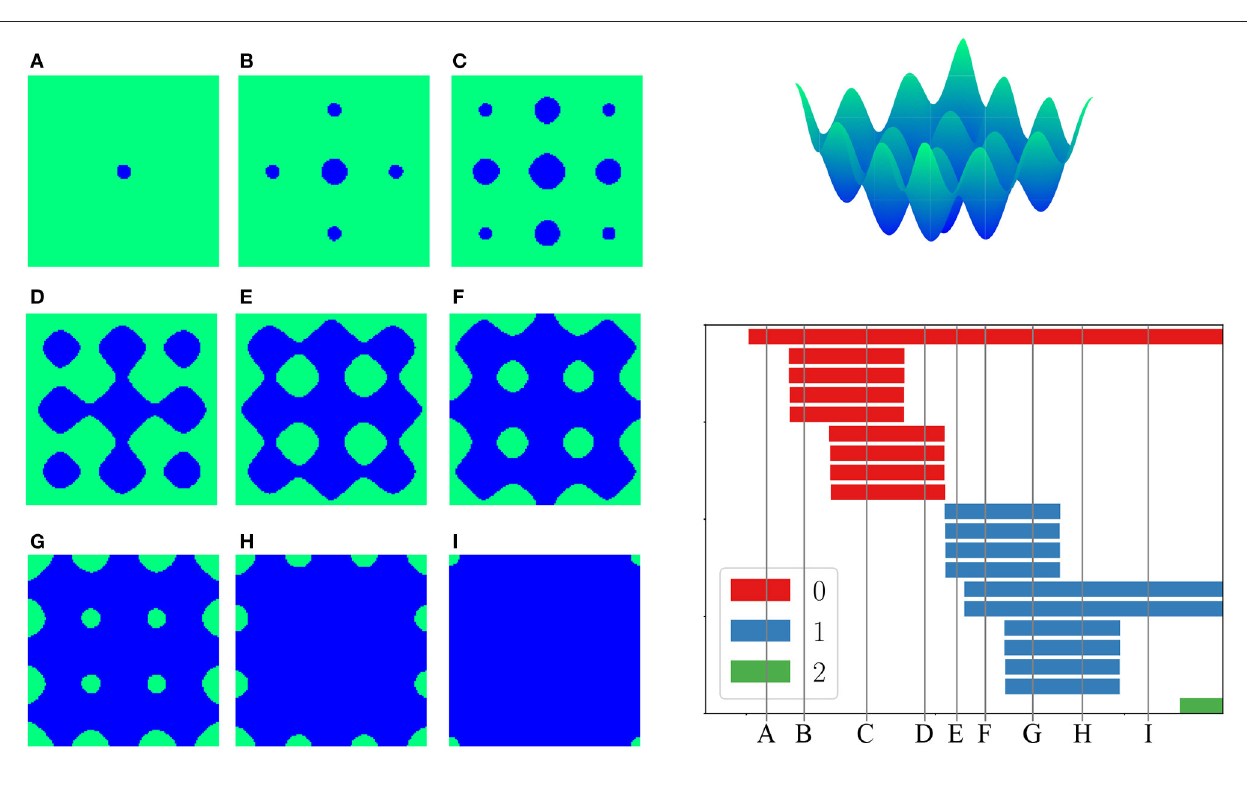
coordinates. This map realizes the conformation space of cyclo- octane as a subset of R 24 , and then we mod out by rigid rotations and translations. Topologically, the conformation space of cyclo- octane turns out to be the union of a sphere with a Klein bottle, glued together along two circles of singularities (see Figure 4 , right). This model was obtained by Martin et al. (2010), Martin and Watson (2011), and Brown et al. (2008), who furthermore obtain a triangulation of this dataset (a representation of the dataset as a union of vertices, edges, and